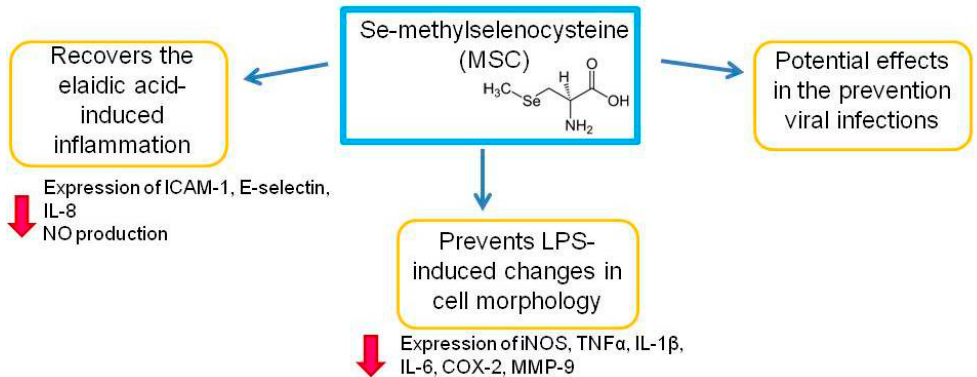
Figure 5. The role of Se-methylselenocysteine in the immune system activation and inhibition of inflammation. ICAM-1—inter-cellular adhesion molecule 1; IL-8—interleukine-8; NO—nitric oxide; iNOS—inducible nitric oxide synthase; TNF α —tumor necrosis factor alpha; IL-1 β —interleukin-1 beta; IL-6—interleukine-6; COX-2—cyclooxygenase 2; MMP-9—matrix metallopeptidase 9. Suppression of the gene expression is indicated by red arrows.